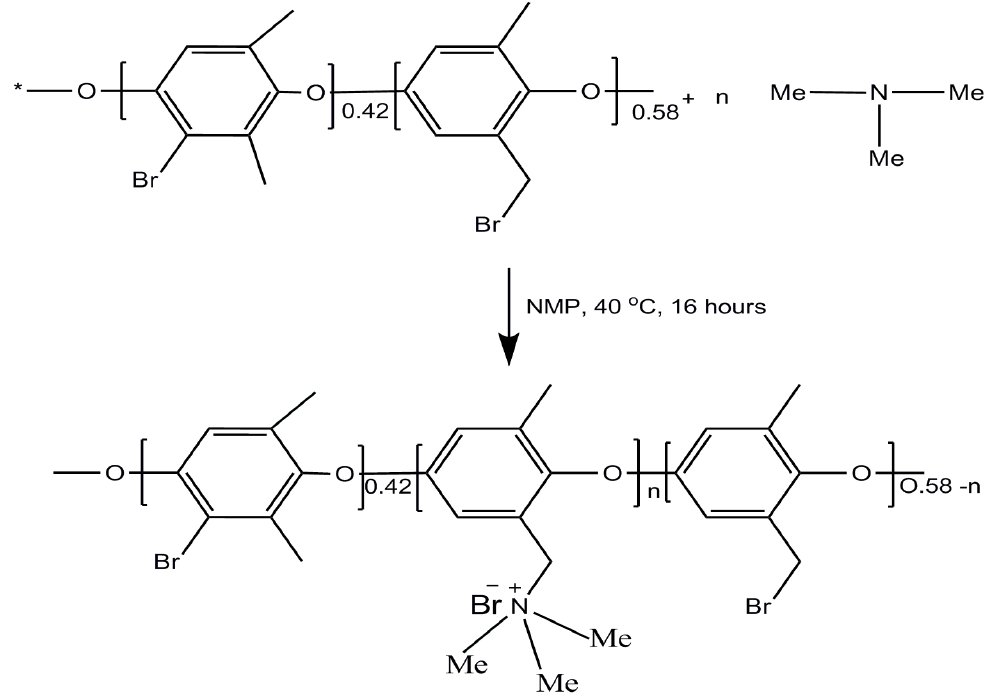
Figure 6. Designing of anion exchange membranes based on BPPO.